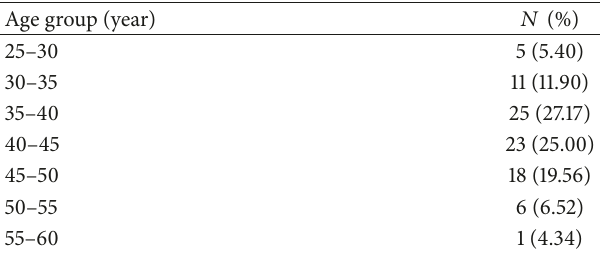
Table 1: Age distribution of healthy